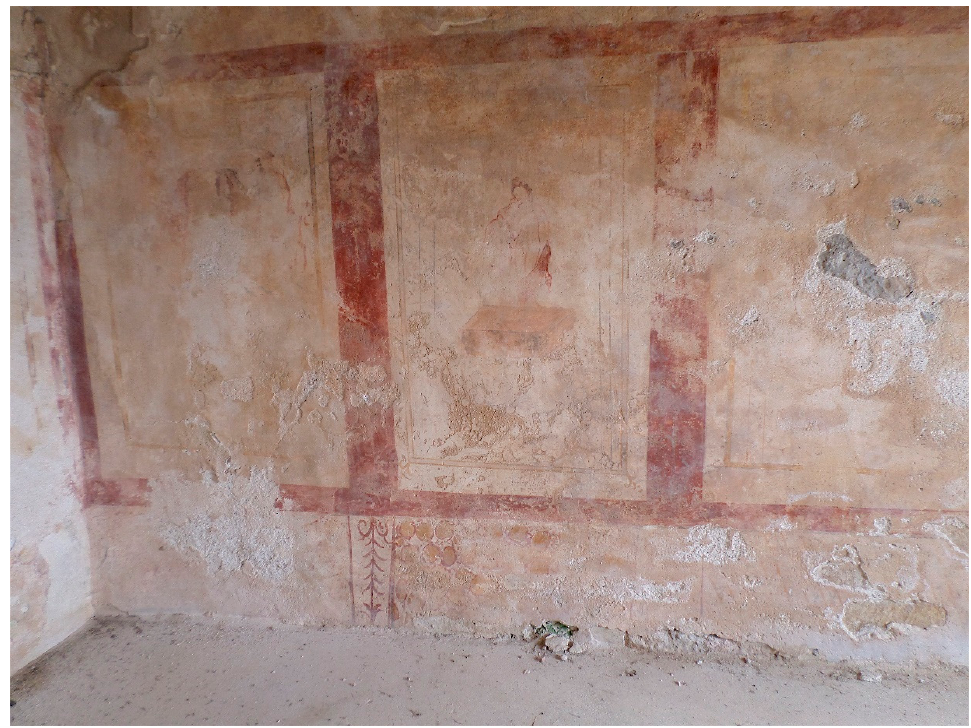
Figure 8. Soluntum, House of Leda, northern wall of triclinium g depicting the Dioscouri (left) and Leda with the Swan (center) (photo by the author).